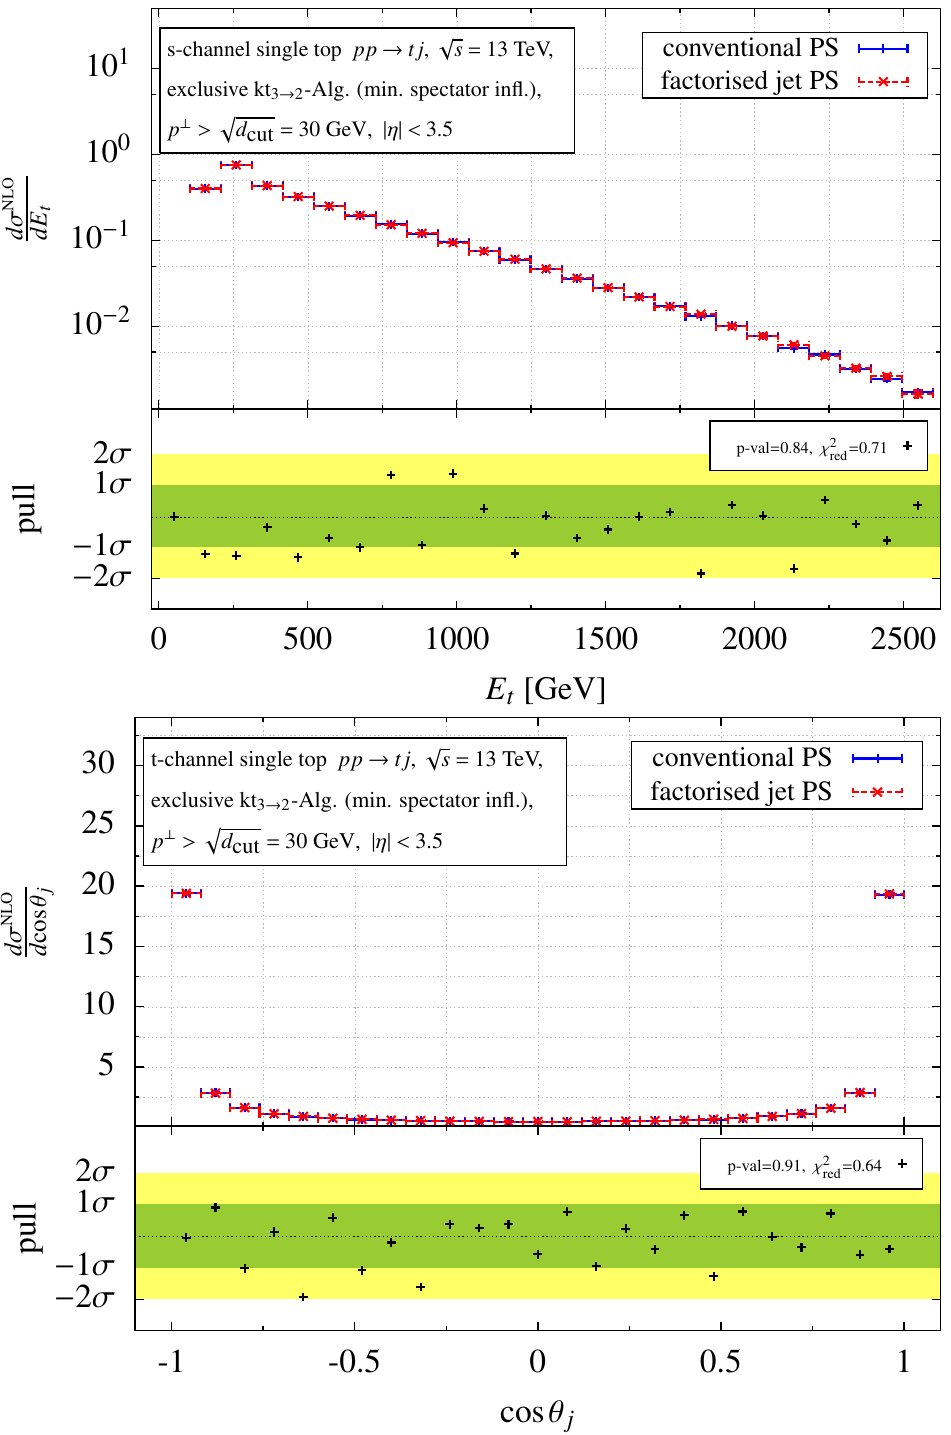
Figure 3 . Energy distribution of the top-tagged jet from the s -channel (upper plot) and the distribution of the polar angle of the light jet from the t -channel (lower plot) calculated using a conventional parton level MC (blue, solid) compared to a calculation using the factorised jet phase space (red, dashed) as described in section 2.3.